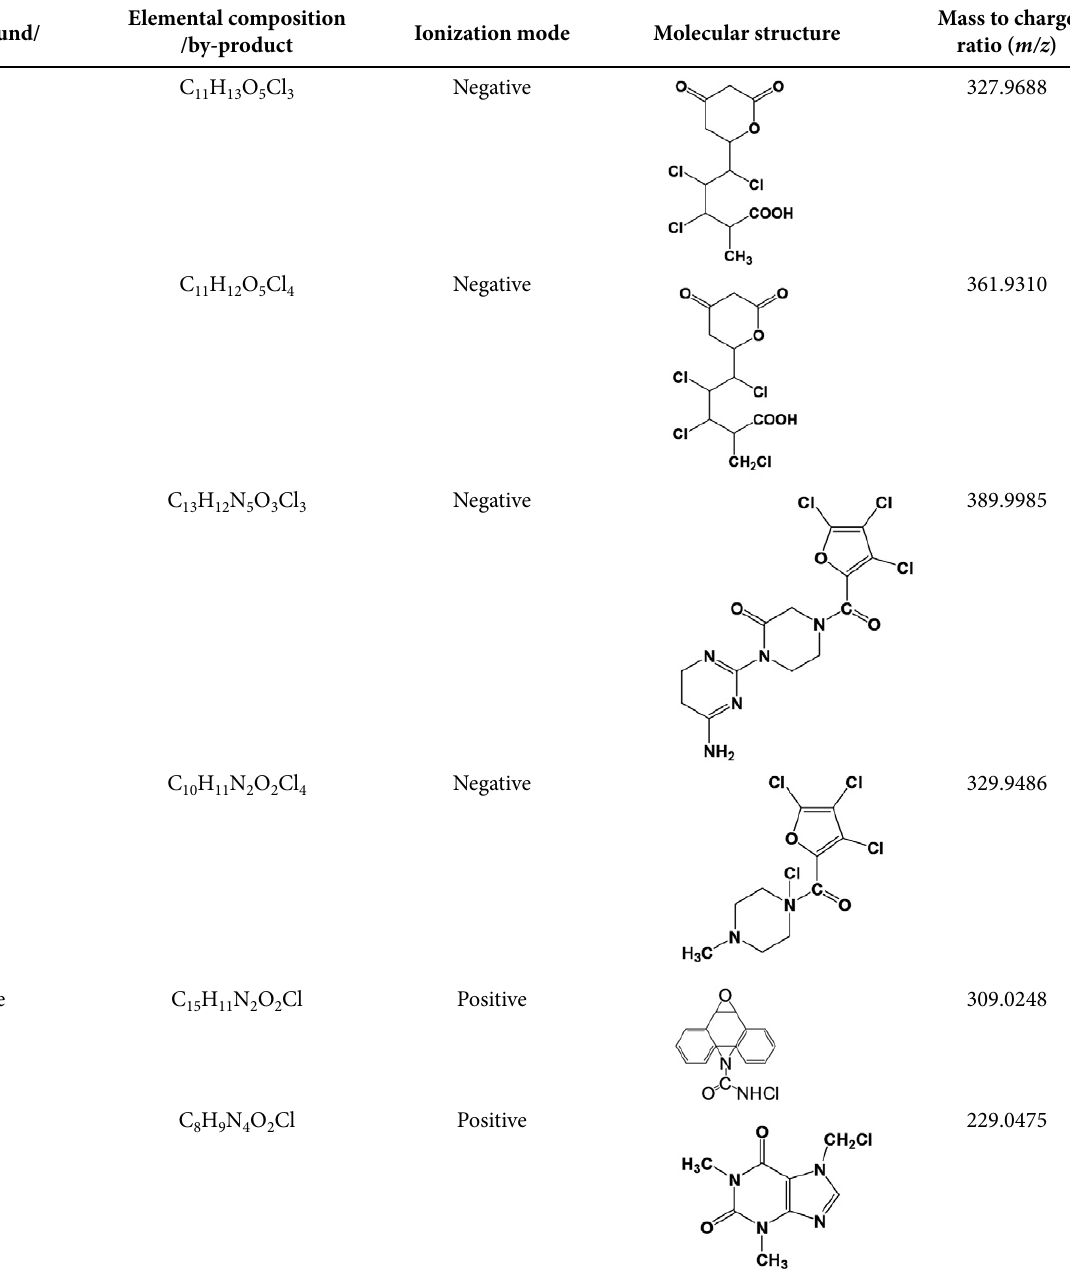
Table 3. Accurate mass measurement for selected pharmaceuticals and their by-products under the conditions 5 V and 5 g/L NaCl. Elemental Parent compound/